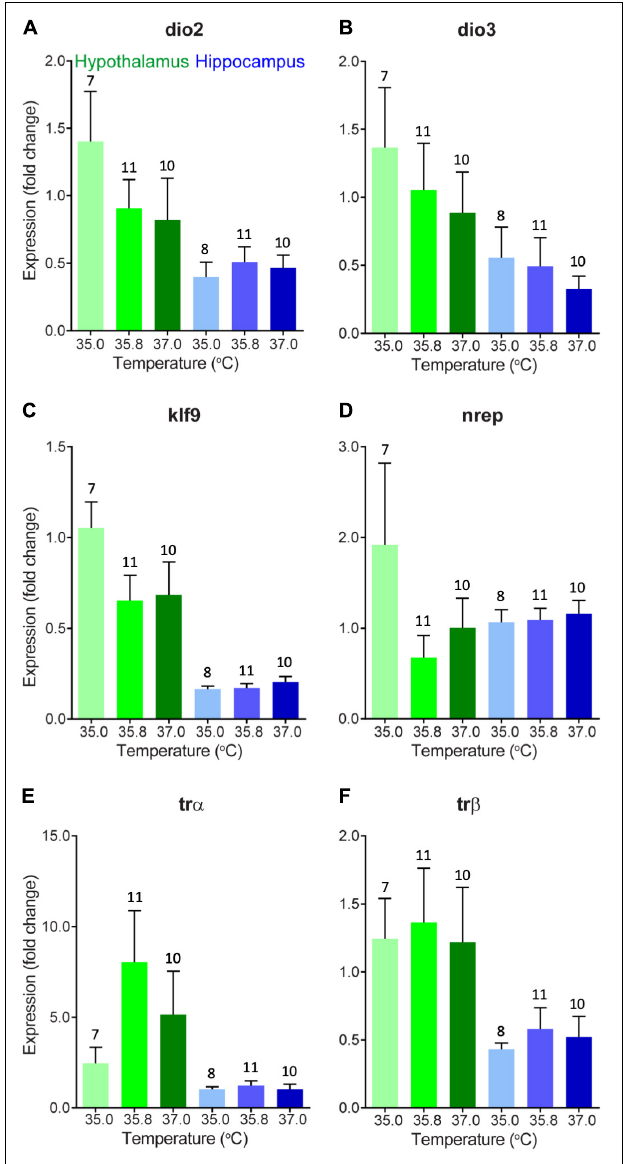
FIGURE 1 | Gene expression (mean fold change compared to 35 ◦ C hypothalamus group as a baseline) of (A) deiodinase 2, (B) deiodinase 3, (C) Krueppel-like factor 9, (D) neural regeneration related protein, (E) thyroid hormone receptor α , and (F) thyroid hormone receptor β in the hypothalamus (green) and hippocampus (blue) of newly hatched (day 0) wood duck ducklings incubated at three different incubation temperatures. Gene expression was measured using quantitative PCR of brain tissue. Fold change is a 10-base fold change because results were transformed using a square exponent (i.e., 2 − (cid:49)(cid:49) Ct ). Error bars indicate standard error. Numbers above bars indicate sample size.